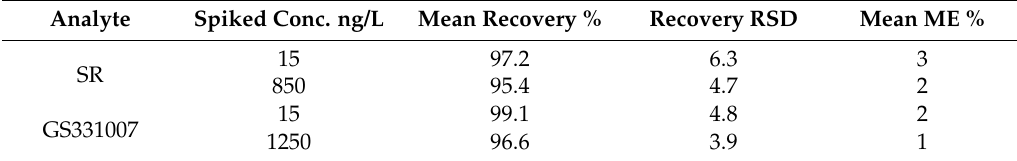
Table 4. Mean recovery (n = 5) and matrix effect (ME) for SR and GS331007 at two different concentration